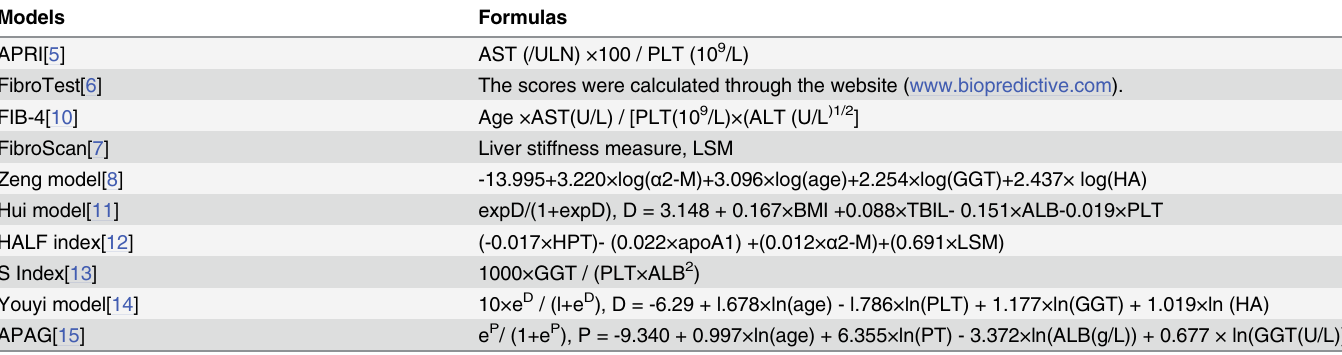
Table 1. The formulas of the ten noninvasive